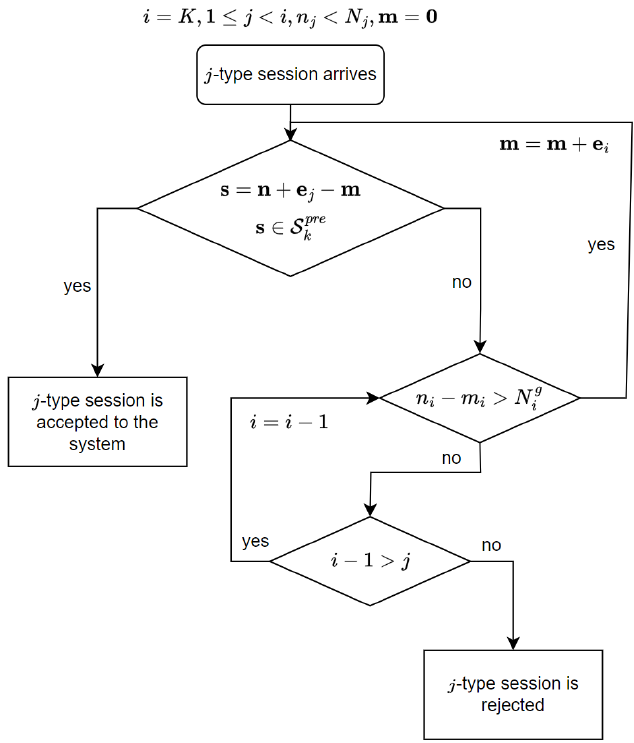
Figure 2. Algorithm for selecting sessions that could be